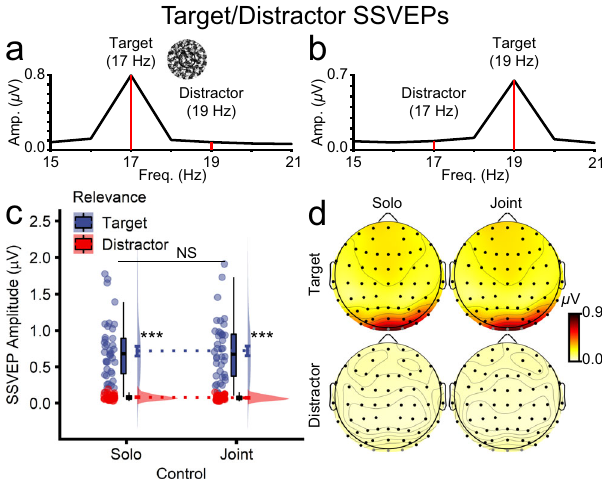
Fig. 7 Neural activity elicited by targets and distractors during solo and joint actions, corresponding to a time window from 0.0 to 2.0 s after action cue onset ( n = 40 participants). FFT amplitudes when the target fl ickered at a 17 Hz or b 19 Hz. FFT SSVEP amplitudes for target and distractor stimuli shown separately for solo and joint control actions, represented as c raincloud plots and d topographies. Note that target and distractor stimuli were always presented concurrently on each trial and that their fl icker frequencies were